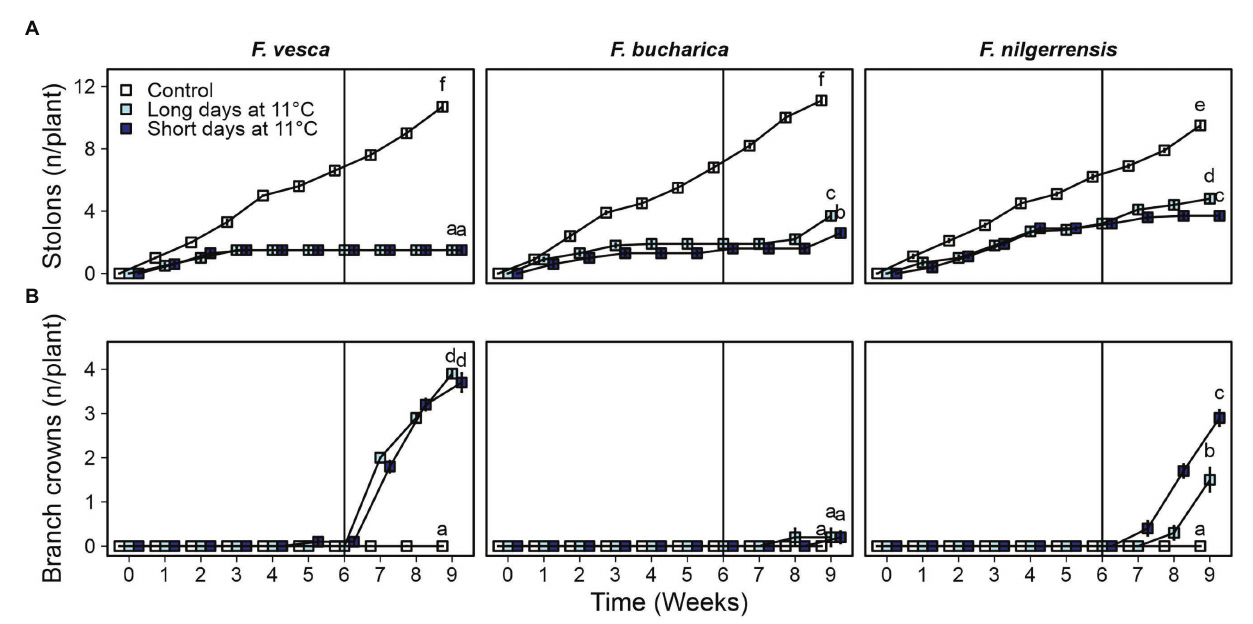
FIGURE 6 | Axillary bud fate in three diploid strawberry species grown under LDs or SDs at 11 ° C. Number of stolons (A) and branch crowns (B) per plant. Stolon- propagated plants were grown under LDs (18-h) or SDs (12-h) at 11 ° C for 6 weeks and subsequently in LDs (18-h) at 18 ° C Control plants were grown continuously under LDs (18-h) at 18 ° C. Number of stolons and branch crowns were recorded weekly until week 9. Error bars represent SEM ( n = 10) and different letters indicate significant differences calculated by ANOVA and Tukey’s test ( p <